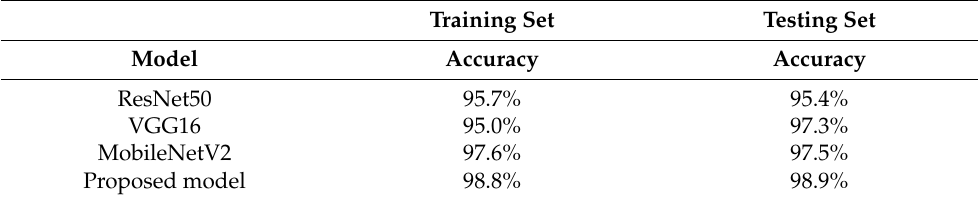
Table 4. Training and testing accuracy results of the other CNN models and the proposed model. Training Set Testing Set Model